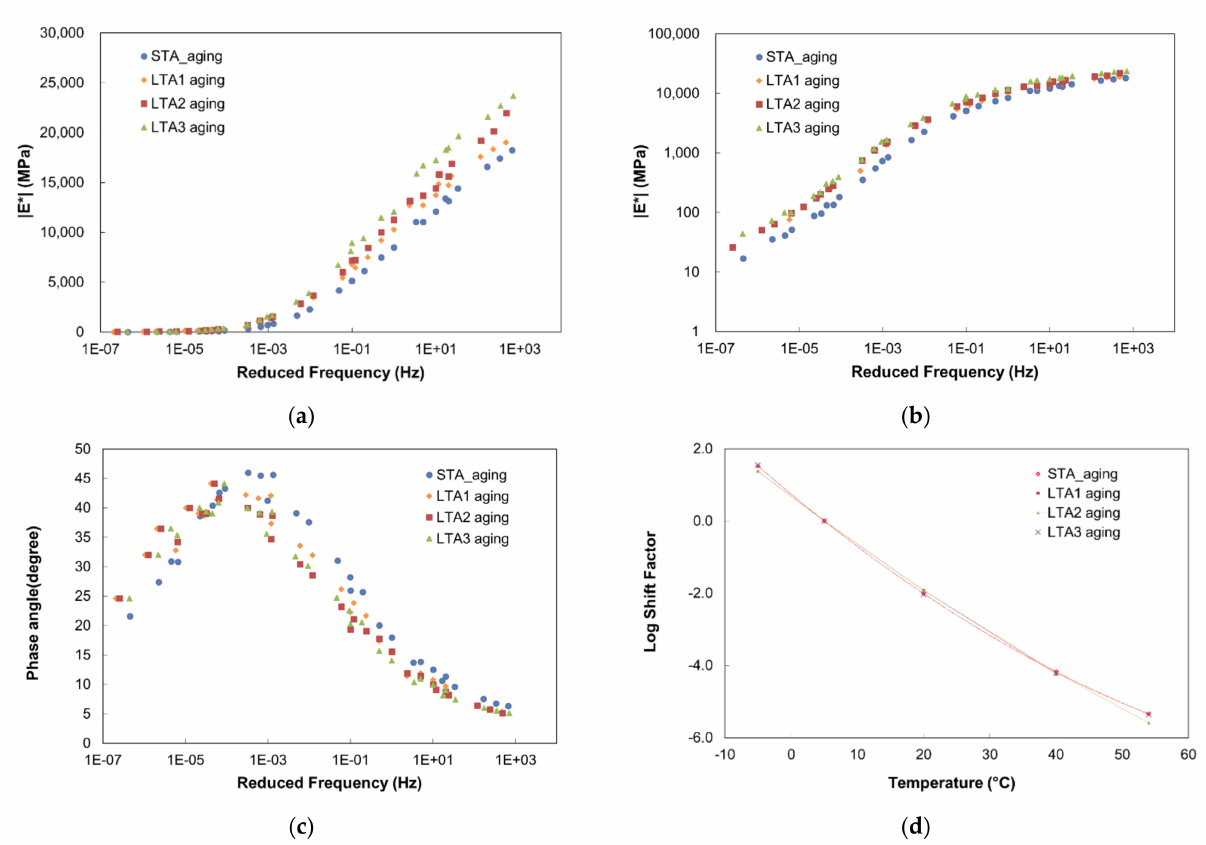
Figure 9. Dynamic modulus test results of WMA for each stage of aging: ( a ) dynamic modulus master curve (semi-log scale), ( b ) dynamic modulus master curve (log-log scale), ( c ) phase angle master curve, and ( d ) shift